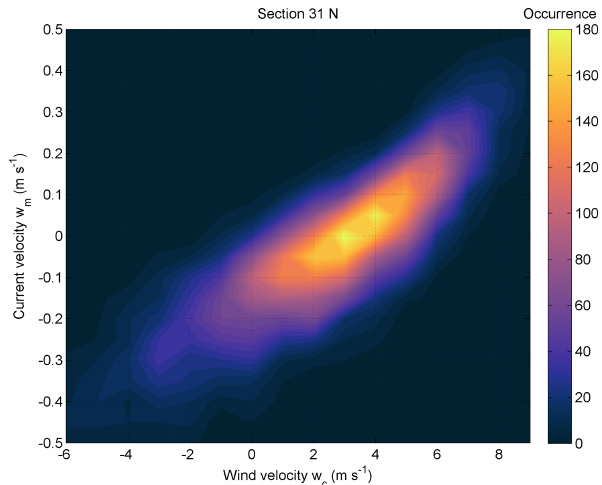
Figure 9. Relation of daily mean SE–NW wind velocity component w c (positive towards NW) and meridional current velocity compo- nent v m (positive northward) in the section at section S1 (see Fig. 8) in 1993–2018. The color scale shows the co-occurrence (number of cases) of respective wind velocity and current velocity component combinations.